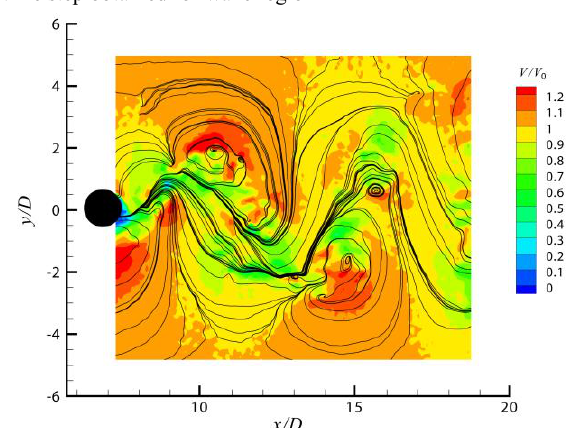
Fig.16 . Normalized velocity magnitude contour plot at second time step obtained for wake region